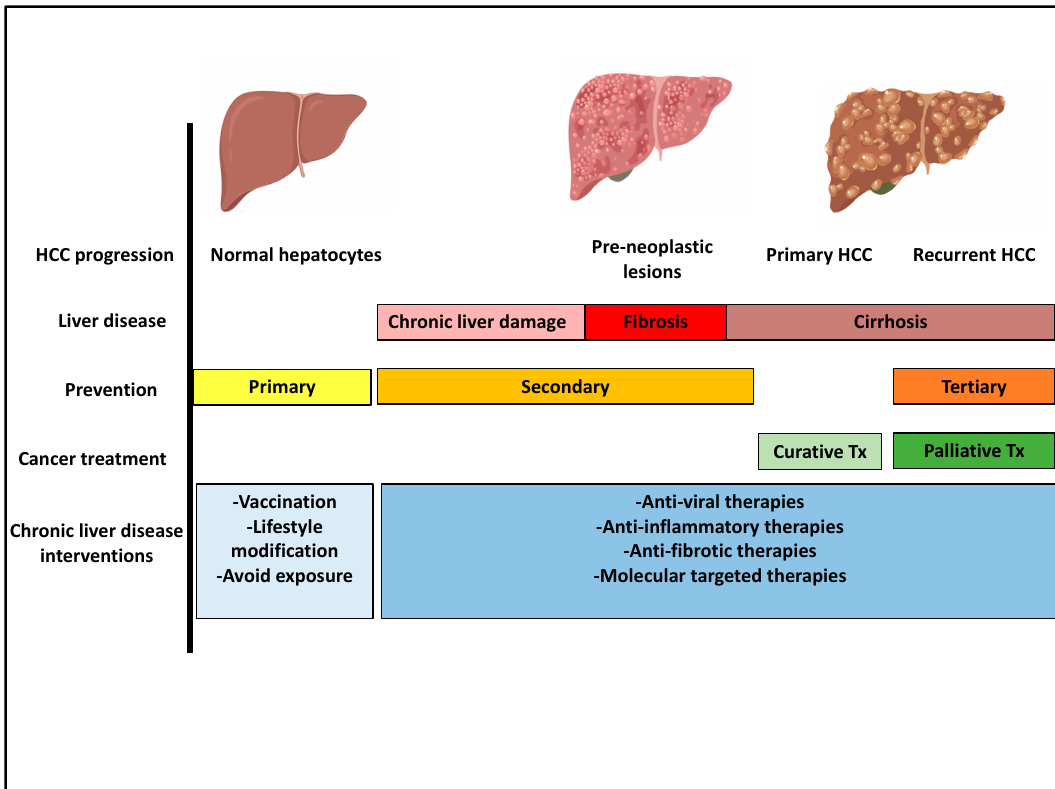
Figure 4. HCC-prevention strategies through the progression of HCC development. HCC prevention strategies, primary, secondary, and tertiary prevention, target various stages of liver disease progression (text for details).